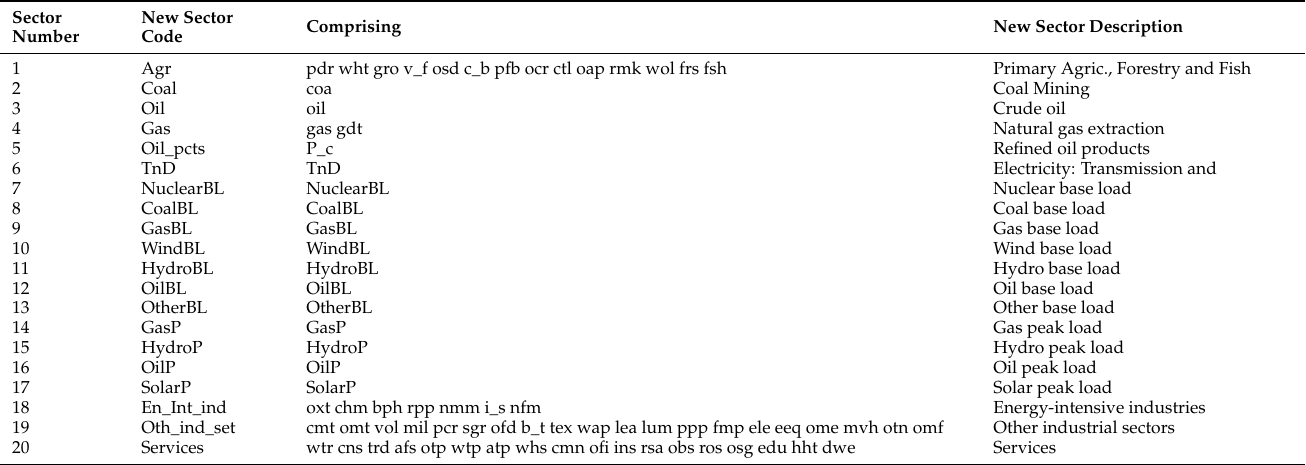
Table 1. Sectors used in the simulations.